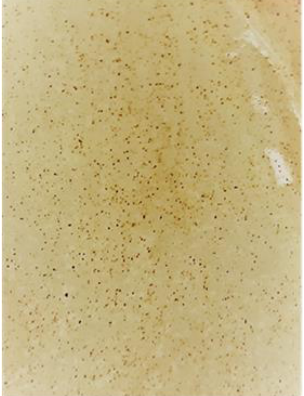
Figure 14. Photo showing the homogeneous distribution of the added Fe 20 Ni 80 magnetic alloys embedded inside the cellulose acetate (CA) polymer matrix .